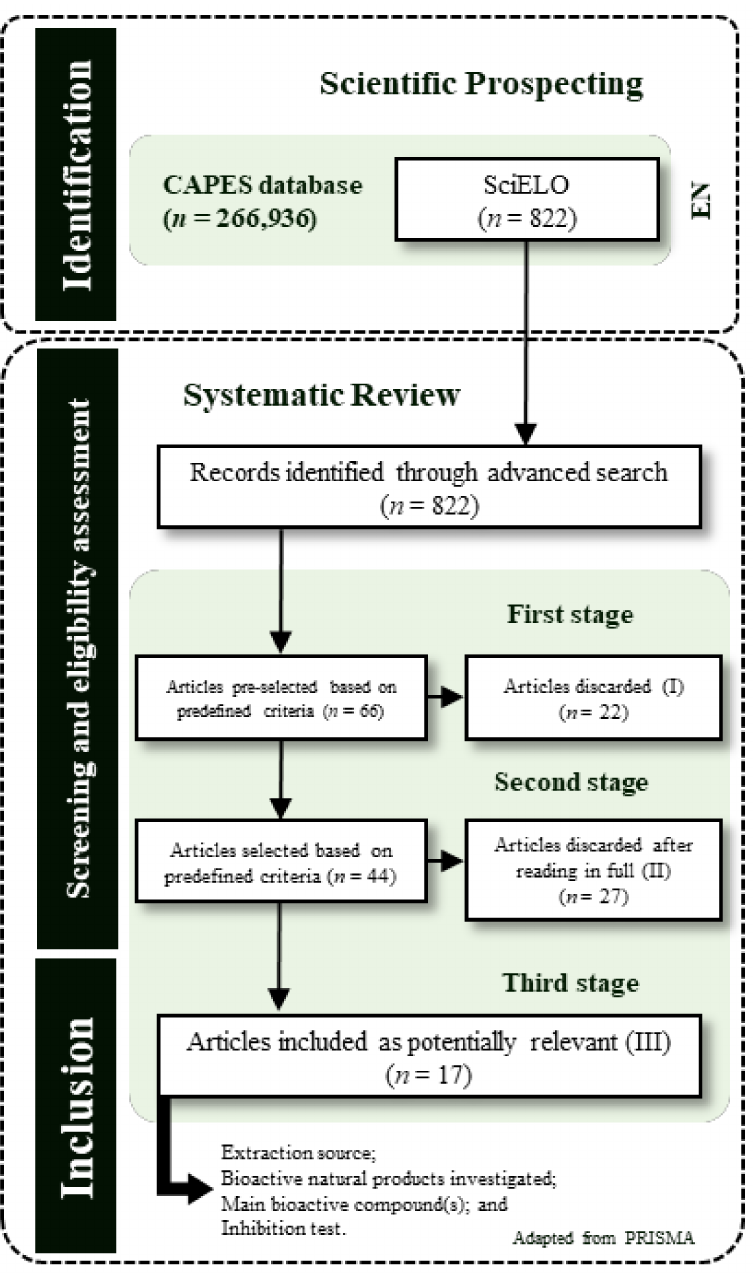
Figure 4. Flowchart of the mixed method used to search the literature for relevant articles on bioactive natural products for microbial control. En, articles written in